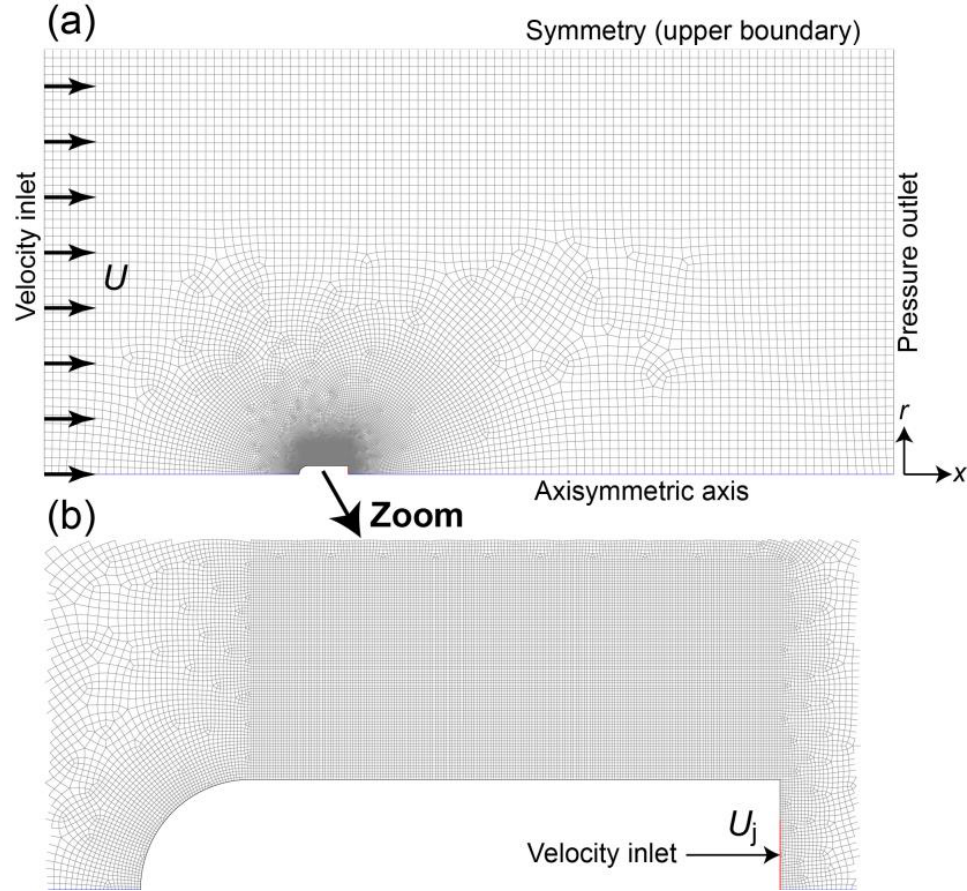
Figure 2. Grid and boundary conditions for the axisymmetric CFD model: ( a ) the whole computa- tional domain; ( b ) the near-body region. The grid shown here is for the jet-propelled body R3-M2, which consists of 36,154 quadrilateral control volumes (CVs).